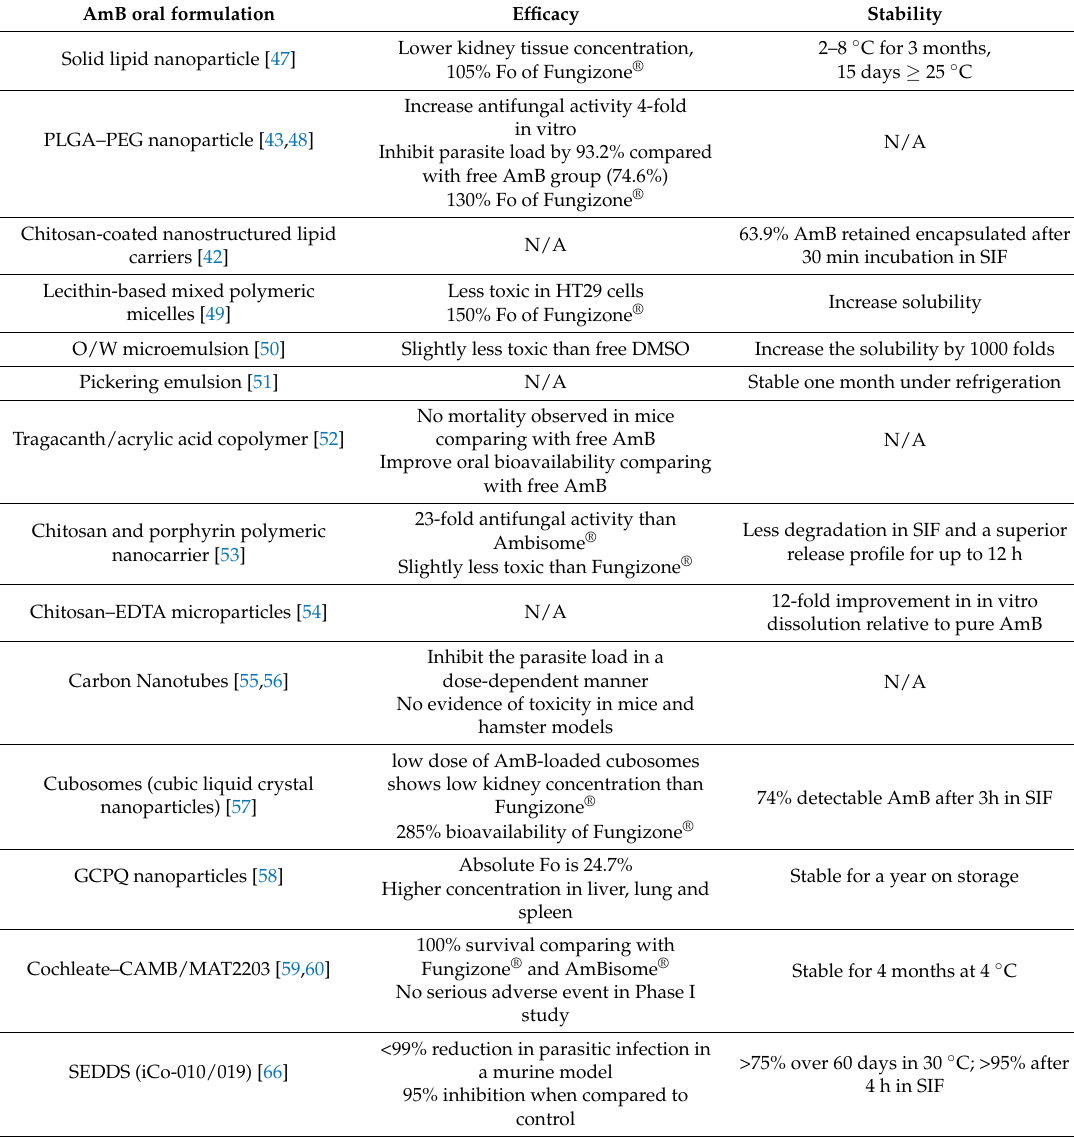
Table 1. AmB oral formulation